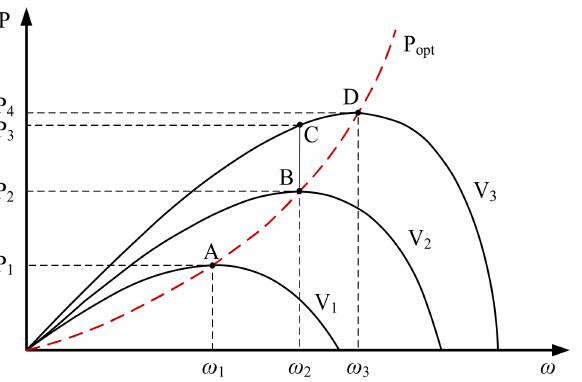
Figure 2. Maximum power characteristic curve of a tidal current energy generation